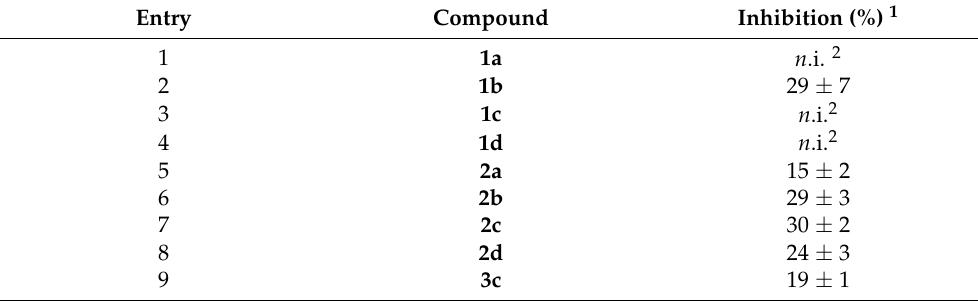
Table 4. Pf DHODH enzyme inhibition data for compounds 1a–d , 2a–d , and 3c .